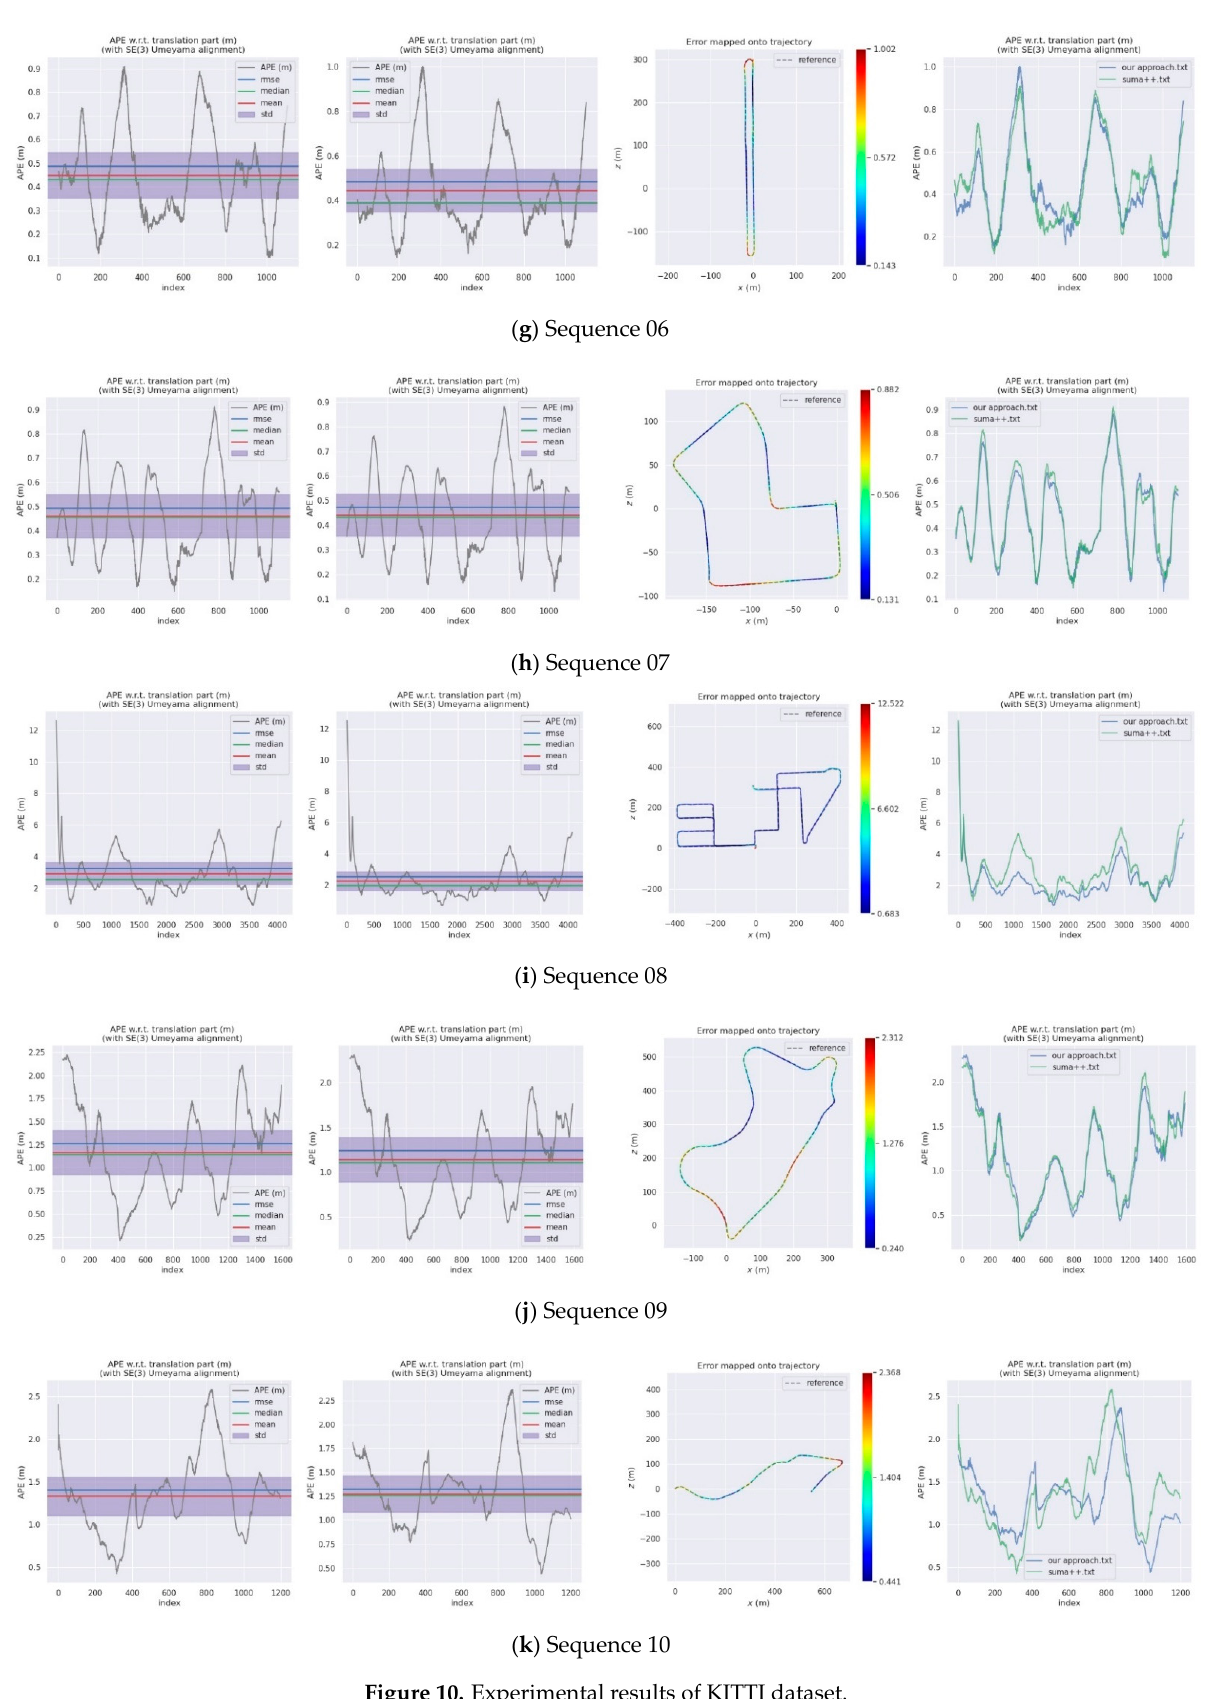
Figure 11. The order of semantic maps is sequence 00 05 08. 4.3. SemanticPOSS Dataset The SemanticPOSS dataset is composed of six groups of campus environmental data collected by Hesai Pandora LiDAR. Table 3 shows the comparison results of the dynamic elements between SemanticPOSS and other mainstream outdoor datasets [49]. Compared